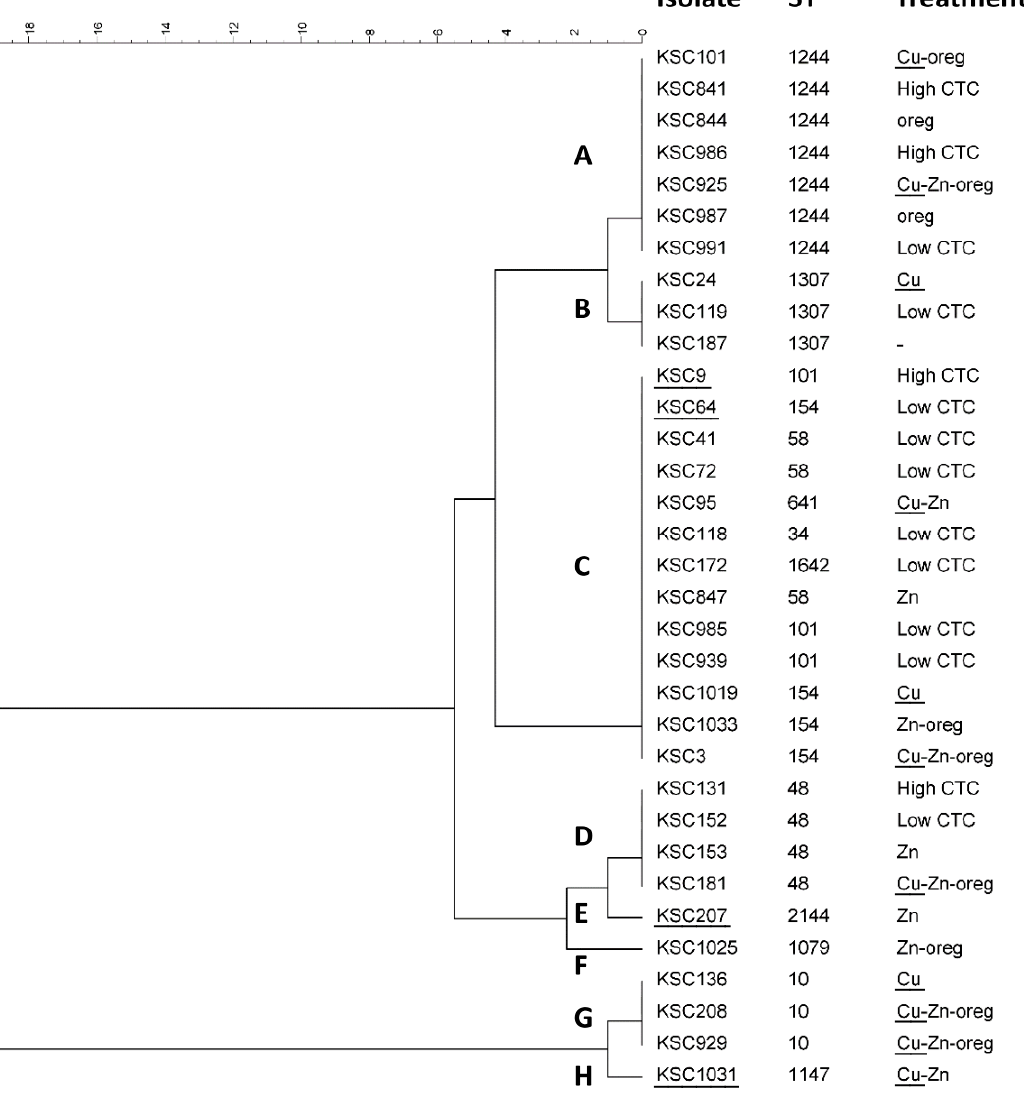
Figure 2. Phylogenetic analysis of the pcoEABCDRSE gene cluster (5487 bp) of all pco -positive isolates in this study, using a categorical (differences) similarity coefficient and unweighted pair group with arithmetic mean (UPGMA) cluster analysis. Treatment groups, including Cu (copper), Zn (zinc), oreg (oregano oil), and high/low-dose chlortetracycline (CTC) are shown. Letters indicating identical SNP groups are also shown in Figure 1A. Isolates used for MIC testing are underlined. ST: sequence type. Both of the two chromosomal Tn 7 -like elements were found in approximately the same position, 300 kbp downstream of the preferential glmS insertion point for Tn 7 [29], much farther than previously reported [30,31]. Neither plasmid harboring the pco / sil gene cluster contained any known virulence factors (using Virulence Finder v1.5 [32]). In one instance, the pcoA gene was interrupted by a transposase, while the sil gene cluster was always intact (Figure